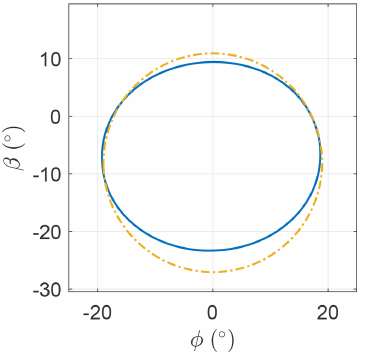
Figure 16. Optimal trajectory (–) and a circle with radius ˜ (cid:56) .